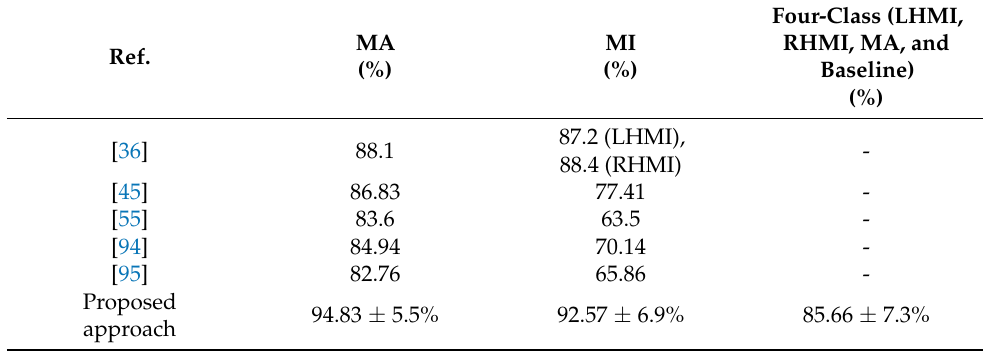
Table 6. Comparison of the proposed framework with the studies using the same